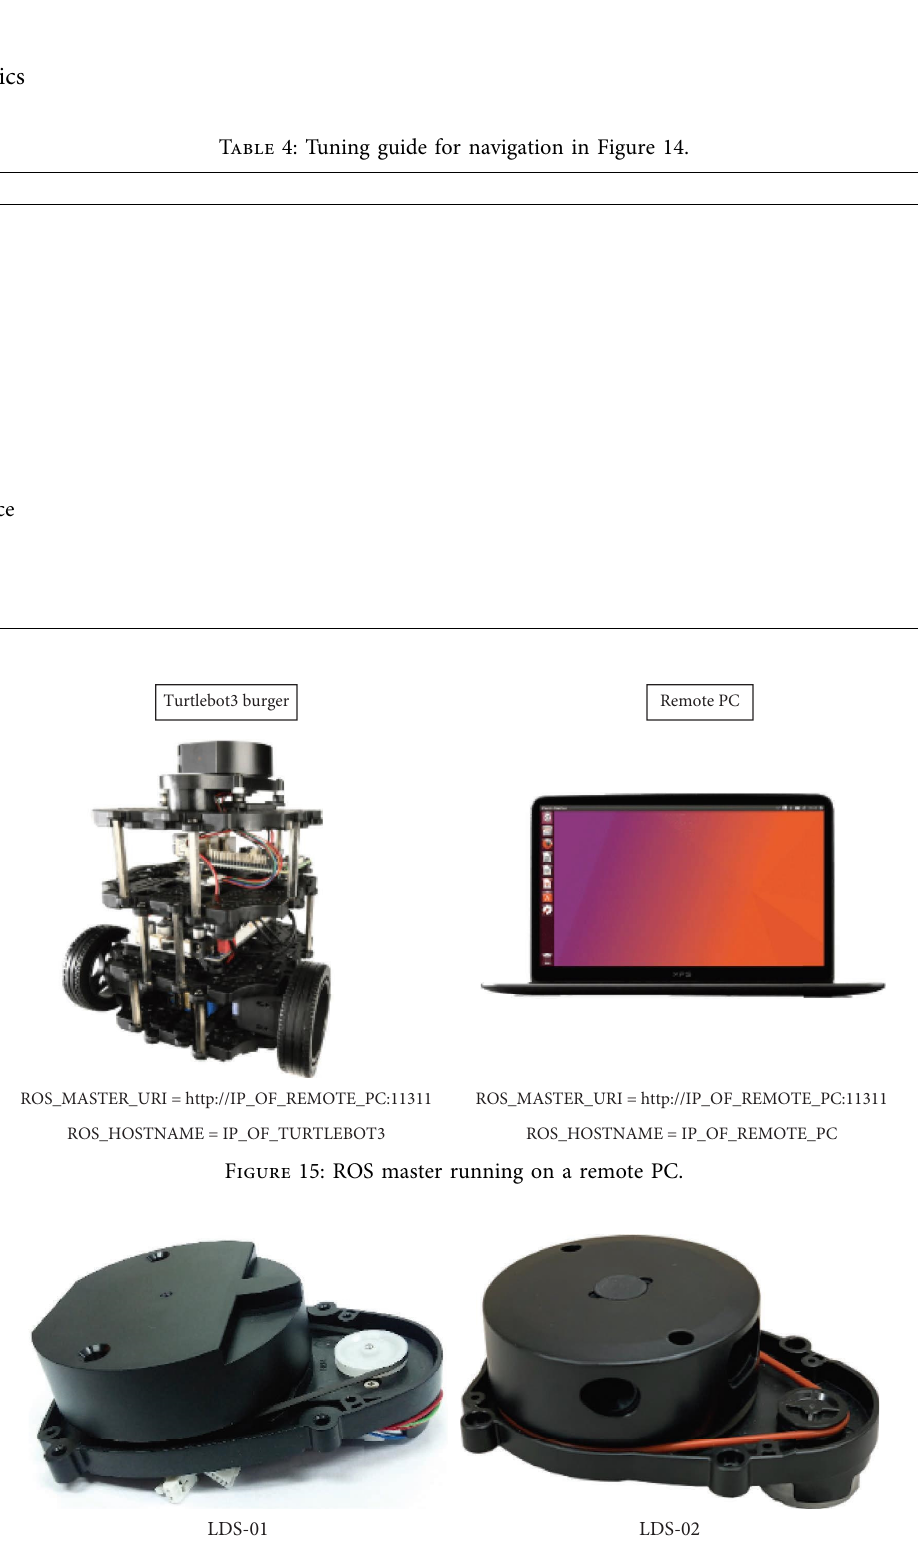
Figure 16: LDS-01 and